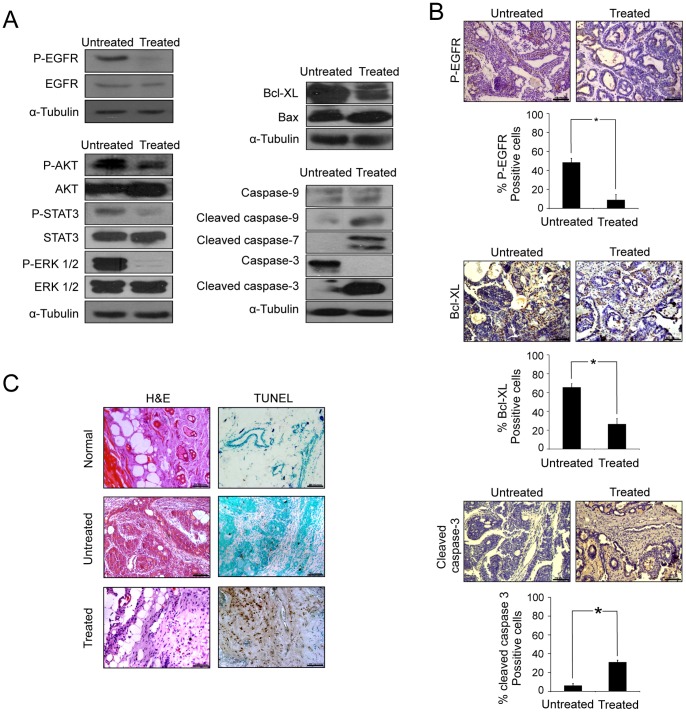

In vivo determination of DPDIM induced EGFR pathway regulation directed to apoptosis.(A), Expression and activation of EGFR, AKT, STAT3, ERK1/2, Bcl-XL, Bax and Caspases-3, 7 and 9 in tumor tissue lysates isolated from untreated and treated groups were checked by IB. (B and C), Tissue sections were prepared from tumors excised at day 21. (B), IHC analysis of phospho-EGFR, Bcl-XL and cleaved caspase-3 was shown in figure. Percentage of positive cells per microscopic field of 5 different fields for each antibody were calculated and represented as a bar diagram with SD. * indicates P<0.0001. (C), H&E staining were done for the histological analysis. TUNEL assay of normal breast, untreated and treated tumor tissue sections. All images were captured under bright field microscope with 20X magnification.